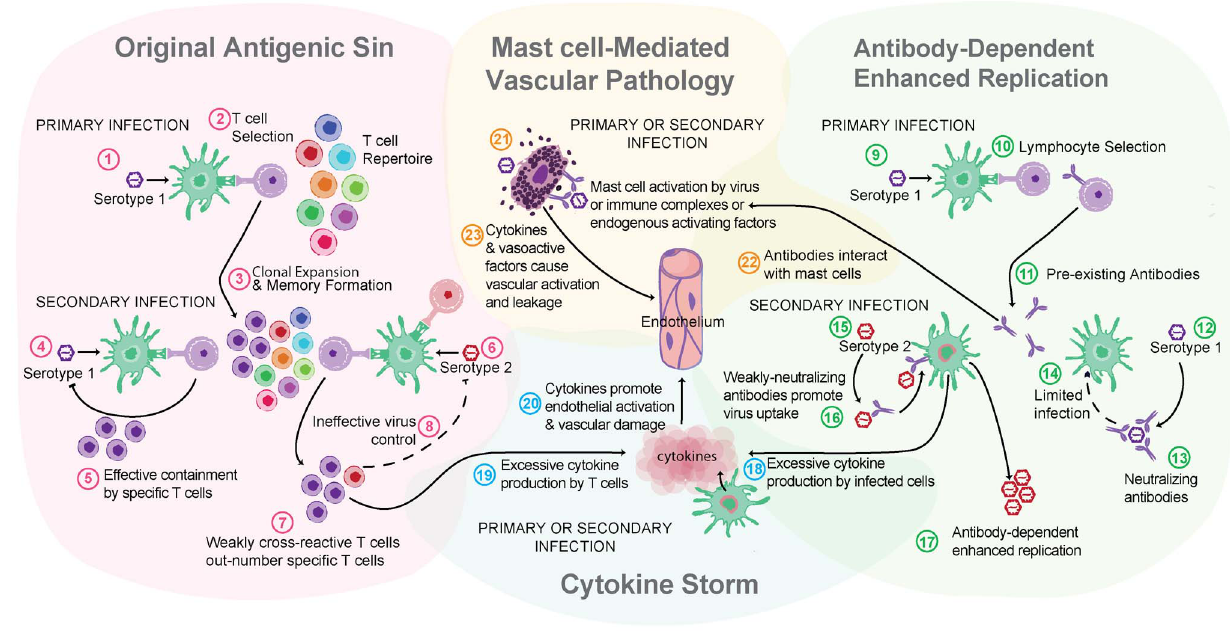
Figure 2. Multiple theories of dengue immune pathogenesis. ‘‘Original antigenic sin’’ has the potential to occur during a DENV secondary infection with a heterologous serotype of DENV. For example, this begins when (1) primary infection occurs with Serotype 1 of DENV, resulting in adaptive immune responses where (2) Serotype 1–specific T cells are selected, activated, and (3) clonally expanded to combat infection. During the resolution of primary infection, memory Serotype 1–specific T cells are formed and are retained in higher frequency in the T cell repertoire than other T naı¨ve cells. (4) A secondary challenge Serotype 1 would evoke a memory recall response and (5) effective containment of infection by highly specific T cells. (6) A secondary challenge with a heterologous strain, Serotype 2, has the potential to reactivate memory T cells that are of greater